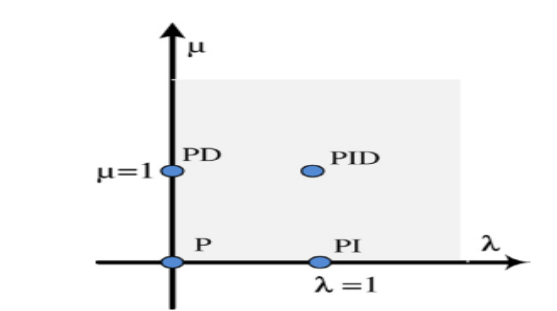
Figure 3. Graphical representation of FOPID controller